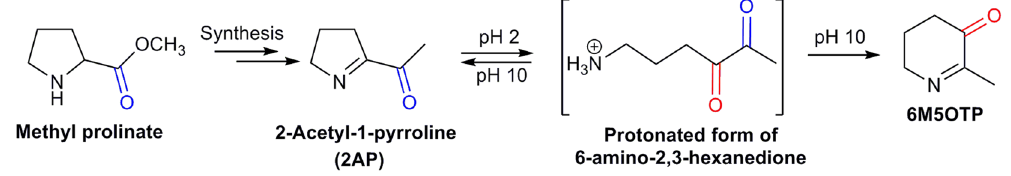
Figure 4. Chemical formation of 6M5OTP through in vitro acid/base workup. 2AP ring opens in excess acid to form an unstable diketone, which cyclises back to 2AP or to 6M5OTP under basic